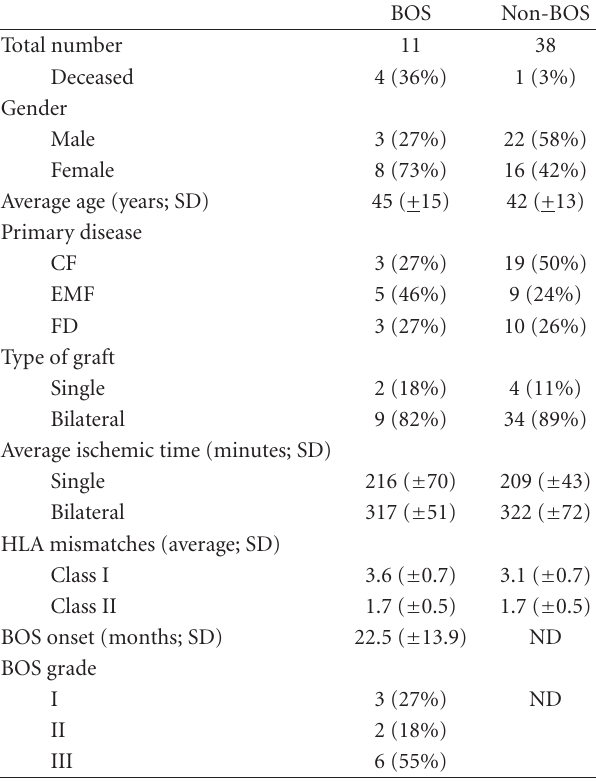
Table 1: Patient characteristics.